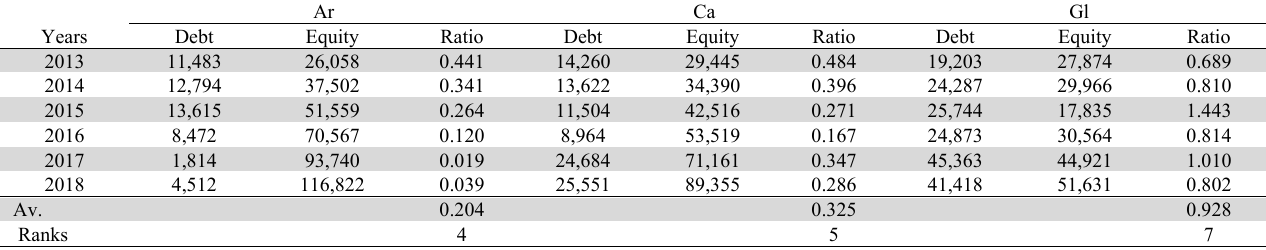
Source: Amounts of debt and equity are taken from the financial statements of the concerned companies Debt-Equity Ratio and rankings of Indian pharmaceutical companies (Rs. in Million) (Continued) Ar Ca Gl Years Debt Equity Ratio Debt Equity Ratio Debt Equity